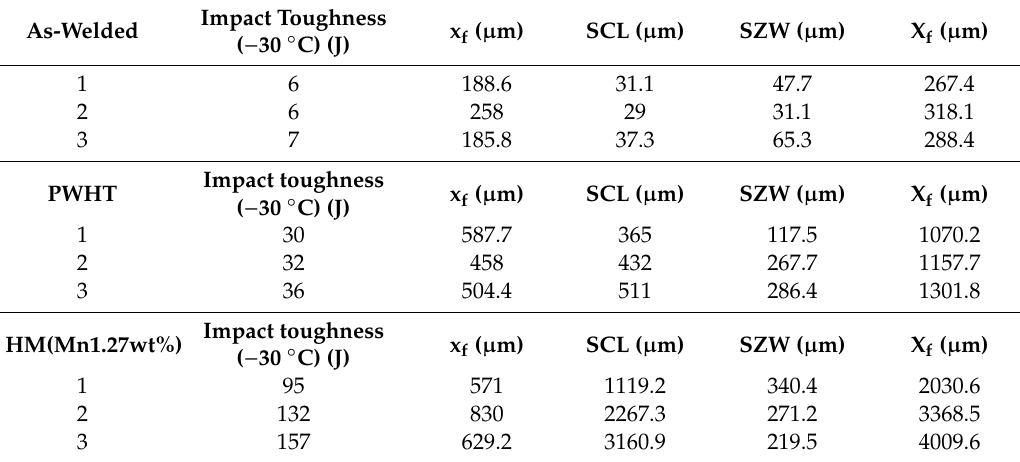
Table 3. Impact toughness of the weld